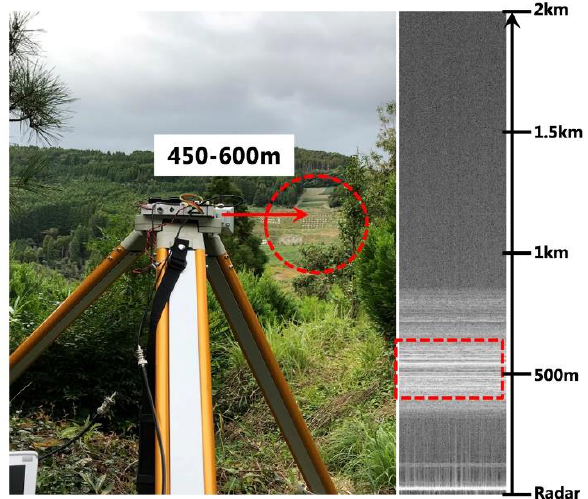
Figure 4. Remote detection distance test conducted around the construction site and its results